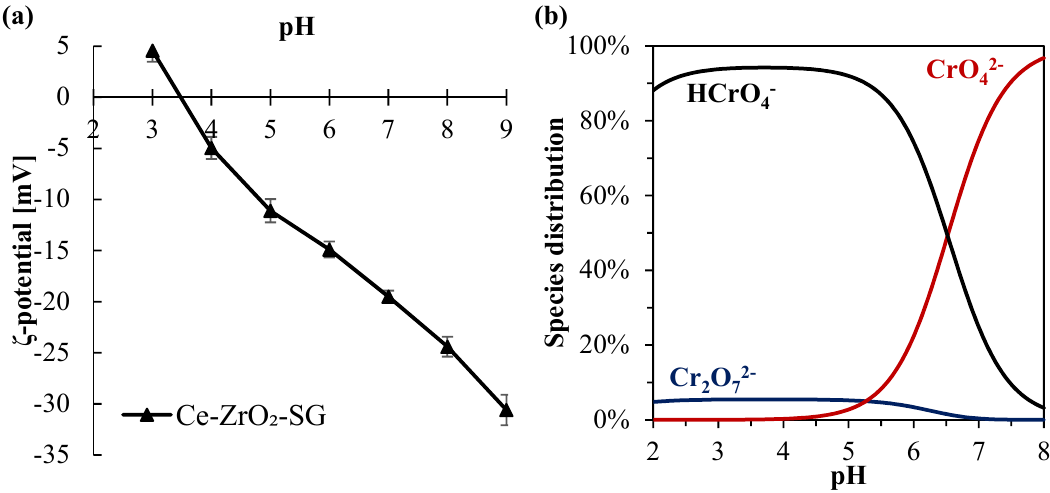
Figure 3. ( a ) Cr(VI) species distribution diagram for a total Cr(VI) concentration of 10 mg L − 1 in water; ( b ) ζ -potential for Ce-doped zirconia.